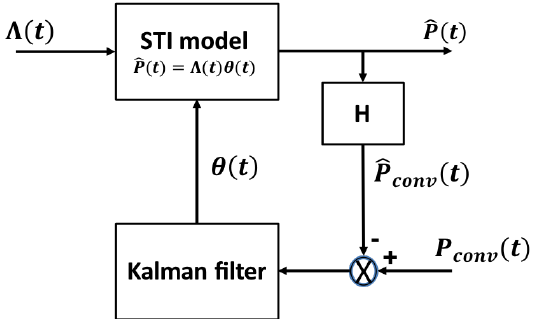
Figure 1. Kalman algorithm